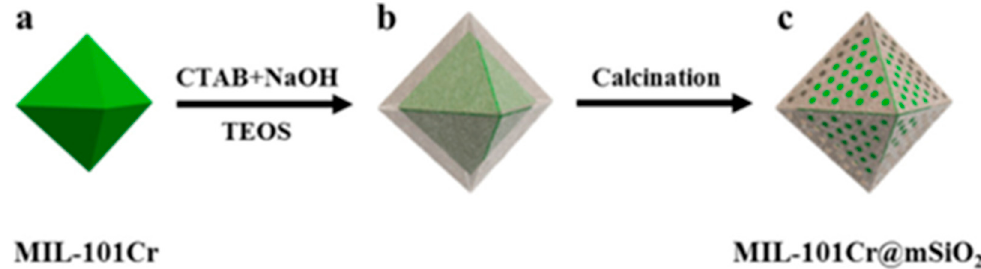
Figure 2. Schematic representation of the synthesis of MIL-101(Cr)@mSiO 2 sample via a sol–gel process to grow silica layer on MOF crystal. ( a ) MIL-101Cr; ( b ) as-synthesized MIL-101(Cr)@mSiO 2 ; ( c ) final MIL-101(Cr)@mSiO 2 . Reproduced from [80], with permission from American Chemical Society, 2018.